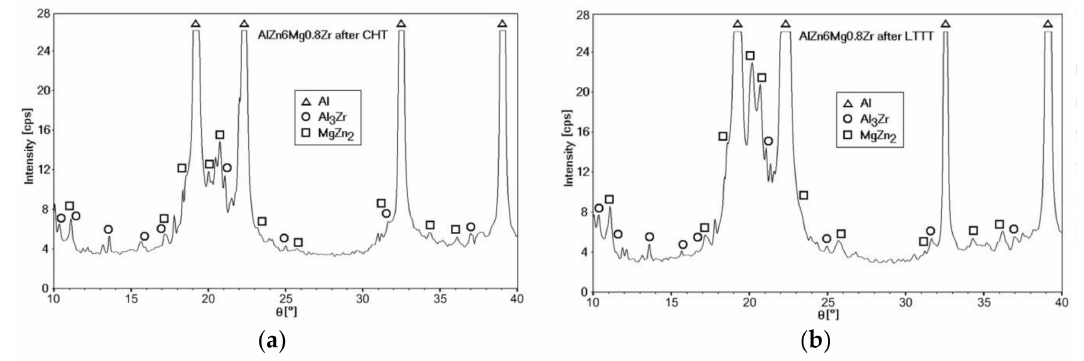
Figure 10. XRD patterns of the AlZn6Mg0.8Zr alloy after: ( a ) CHT (T s = 500 ◦ C; T a = 150 ◦ C; τ a = 12h); ( b ) LTTT (T s = 500 ◦ C; 30%; T a = 150 ◦ C; τ a =